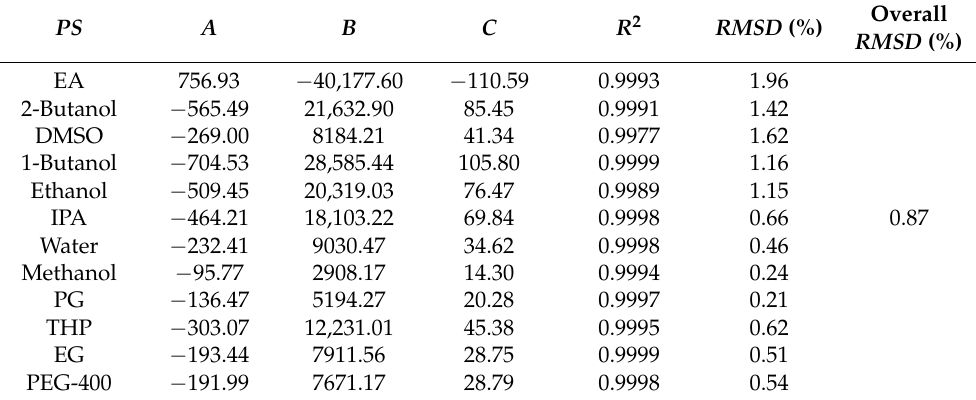
Figure 4. Correlation of experimental natural logarithmic solubilities (ln x e ) of ECT with the Apelblat model in various pure solvents as a function of 1/ T ; symbols represent the experimental ln x e values of ECT and the solid lines represent the ln x Apl values calculated by the Apelblat model. The Apelblat correlation results are listed in Table 5. Table 5. Results of the Apelblat model in terms of the Apelblat parameters ( A, B and C ), R 2 and root mean square deviation ( RMSD ) for ECT in various PS b .